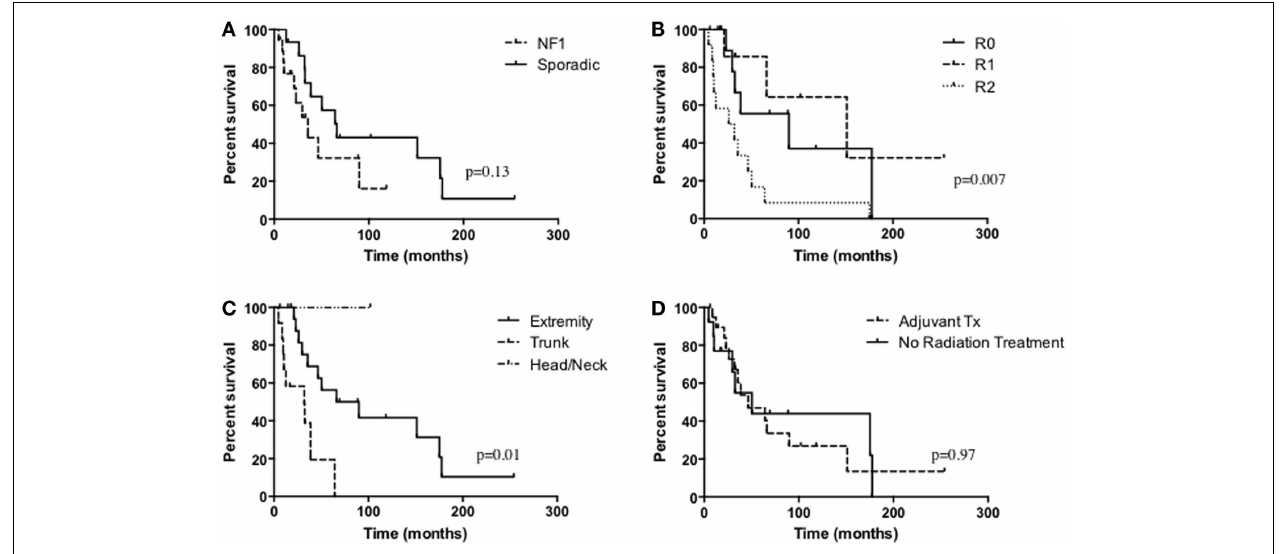
FIGURE 2 | Overall survival of (A) NF1-associated MPNST compared with sporadic MPNST, p = 0.13; (B) the extent of resection, p = 0.007; (C) tumor location, p = 0.01; (D) radiation treatment versus no radiation treatment, p = 0.97